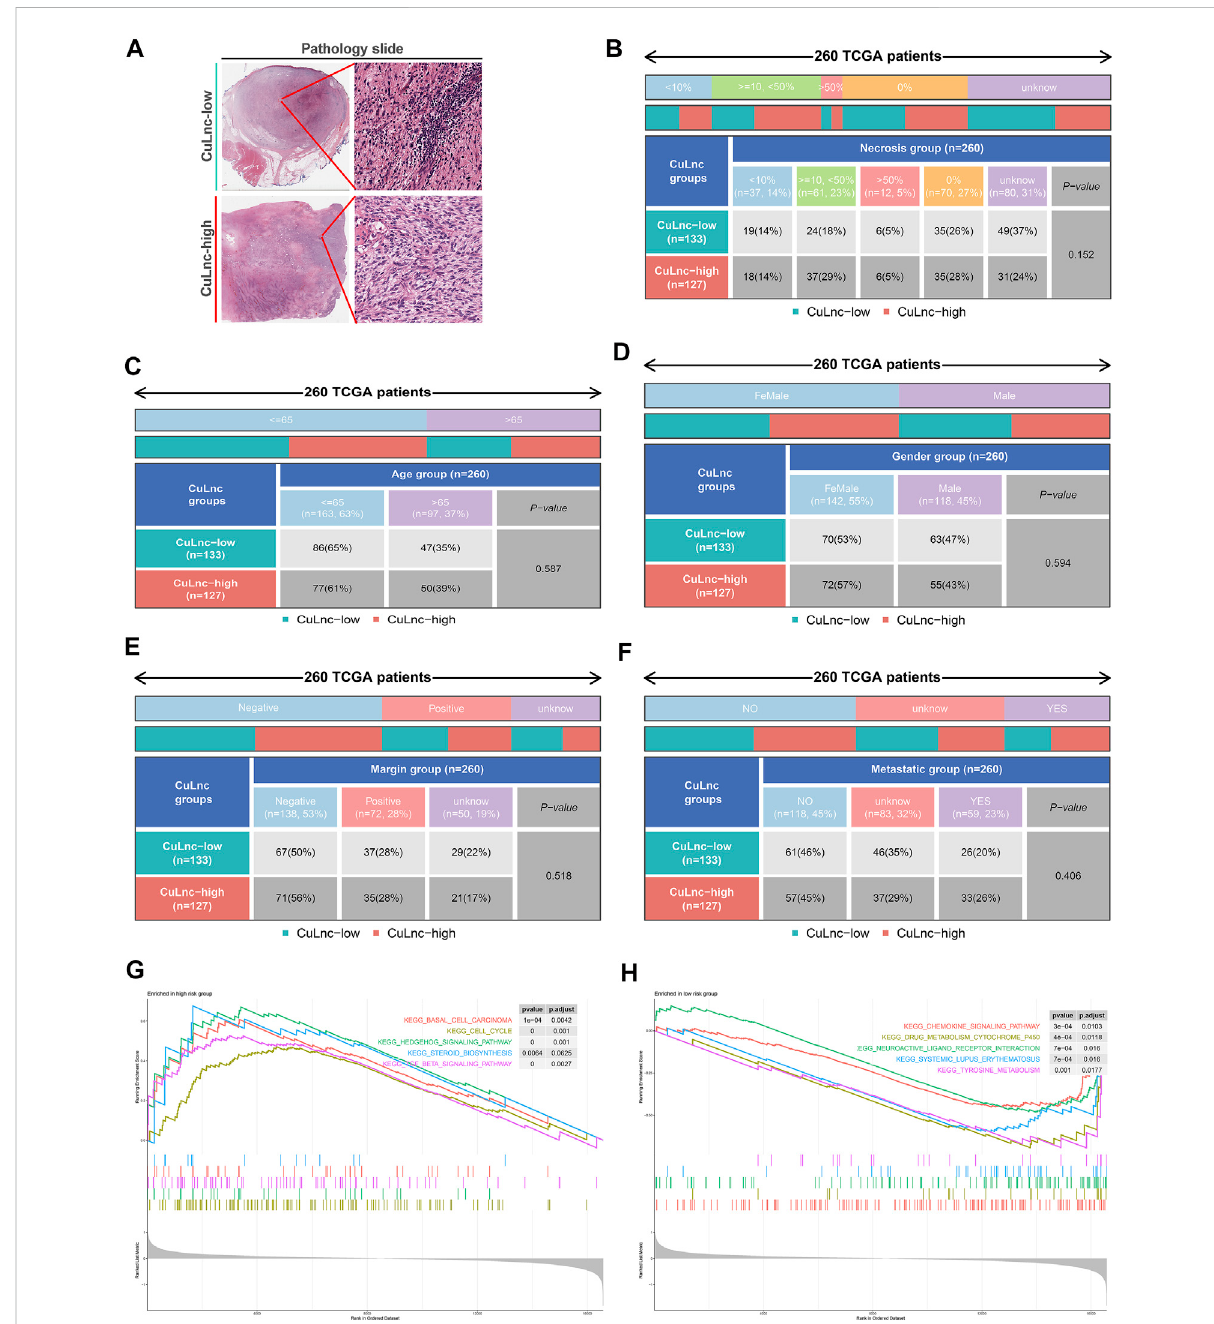
FIGURE 2 TheclinicopathologicalandbiologicalcharacteristicsoftheCuLncScoregrouping. (A) RepresentativeimagesofthepathologicalHEstainingof thehighorlow-riskgroupfromtheTCGAdataset.Necrosis (B) ,Age (C) ,Gender (D) ,Margin (E) ,andMetastatic (F) characteristicsofhighandlow-risk groups in TCGA-SARC. KEGG pathway enrichment analysis in the high-risk group (G) and low-risk group (H)